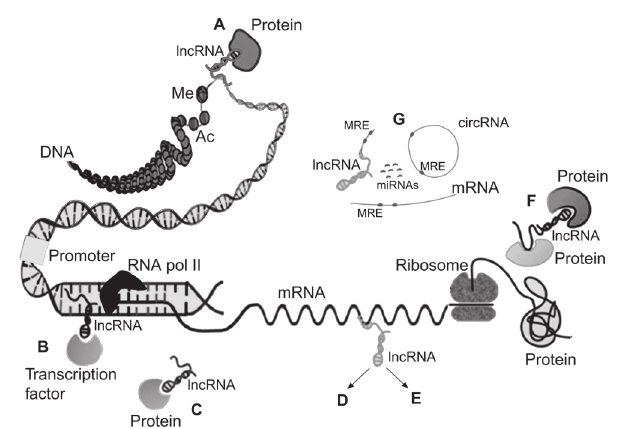
Figure 3. Functions of lncRNAs (Abbreviations: Me: Methyl, Ac: